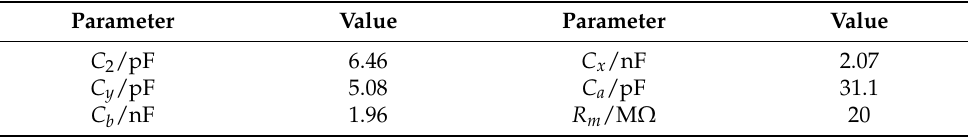
Table 3. Calibrate system capacitance and resistance parameter values.